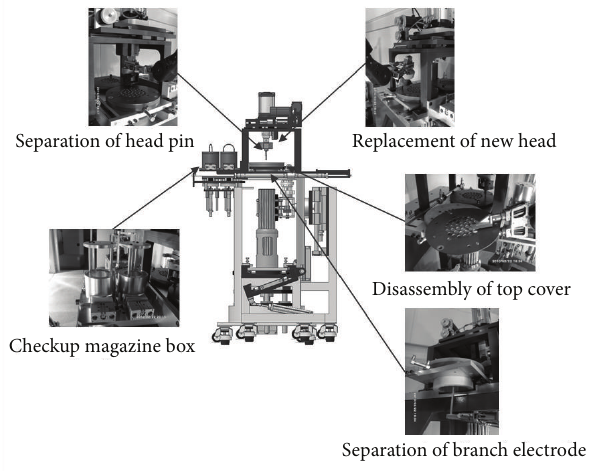
Figure 14: Illustration of manipulating various main